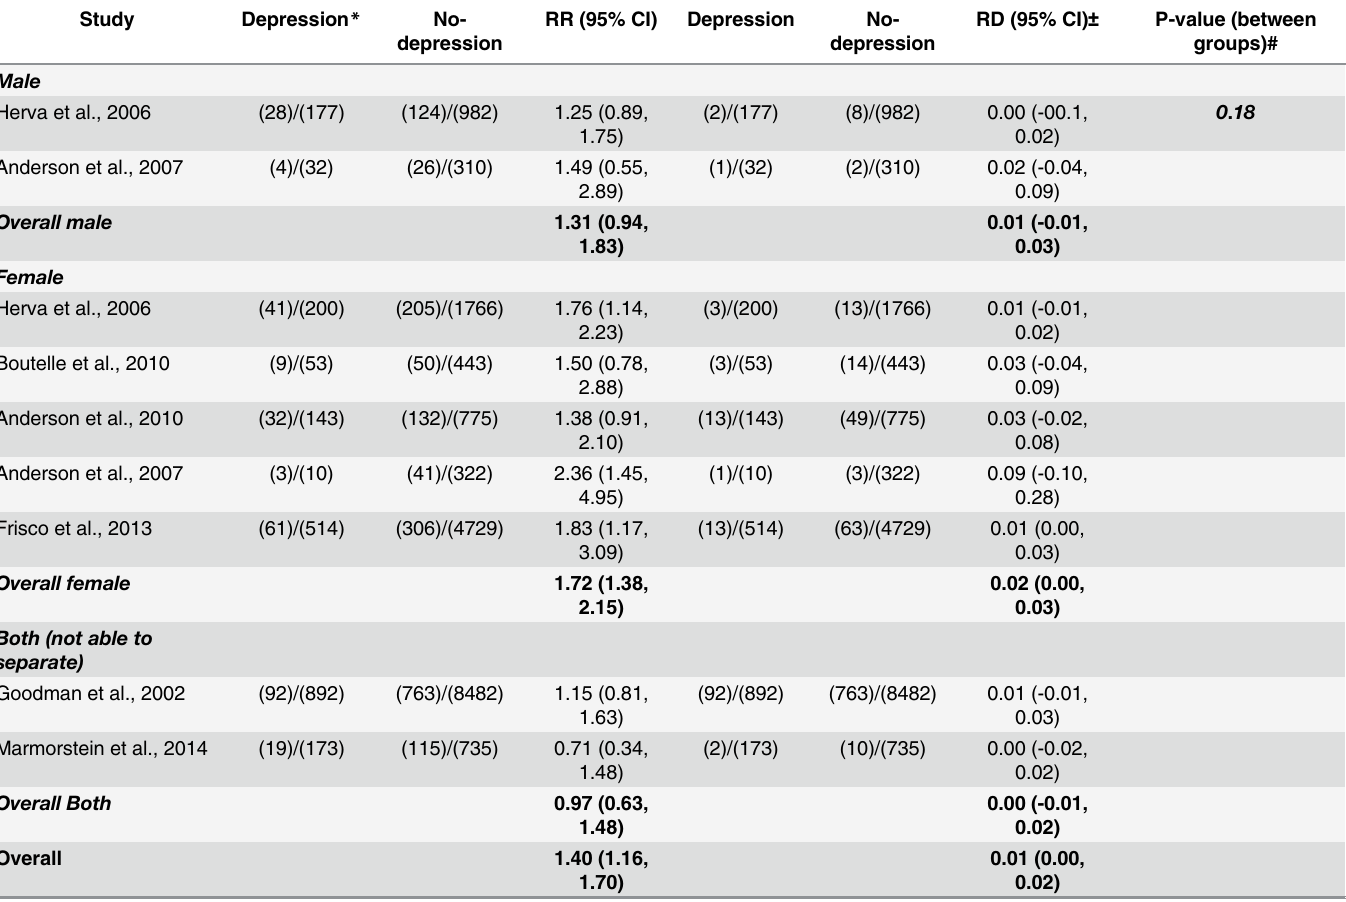
Table 4. Pooled estimates of incidence obesity leading to depression measured in terms of relative and absolute risk using quality effect